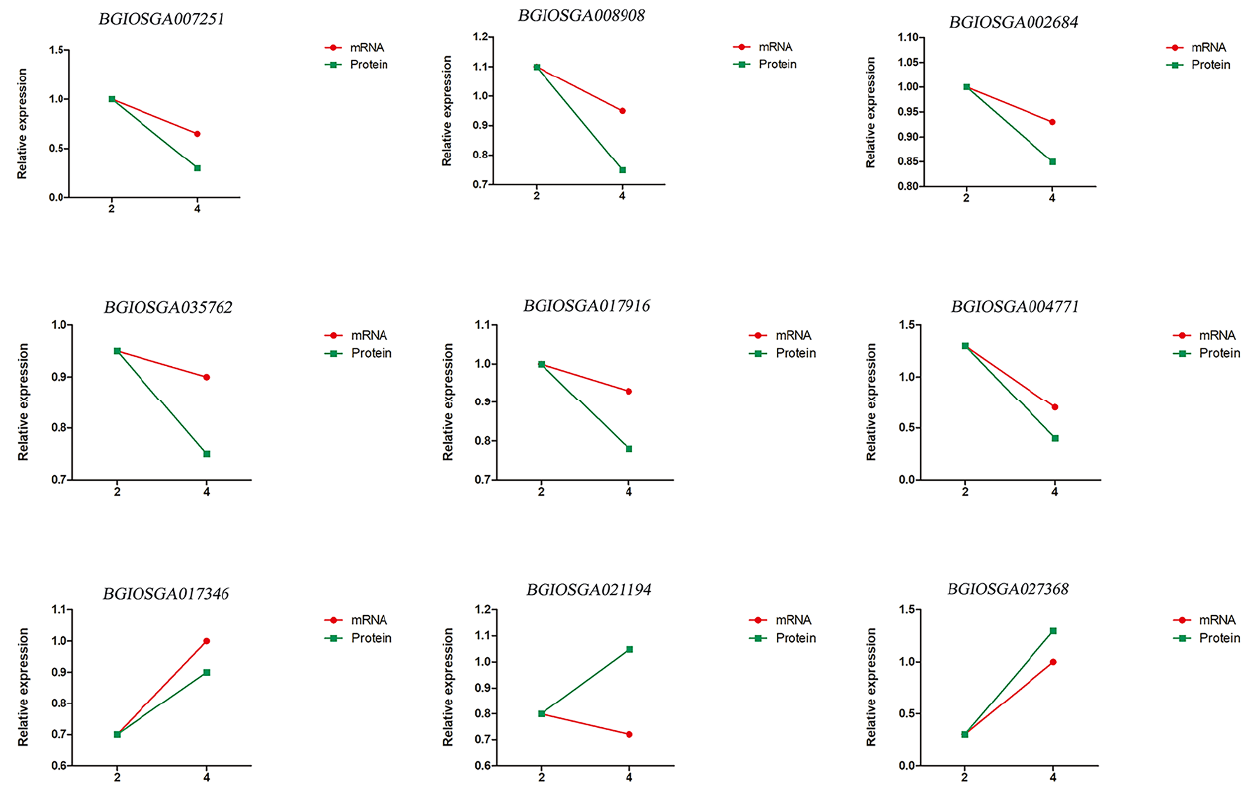
Figure 7. The qRT-PCR (real-time reverse transcription-PCR) validation of eight randomly selected differentially expressed proteins. The green columns represent relative protein expression and the red lines represent relative gene expression.